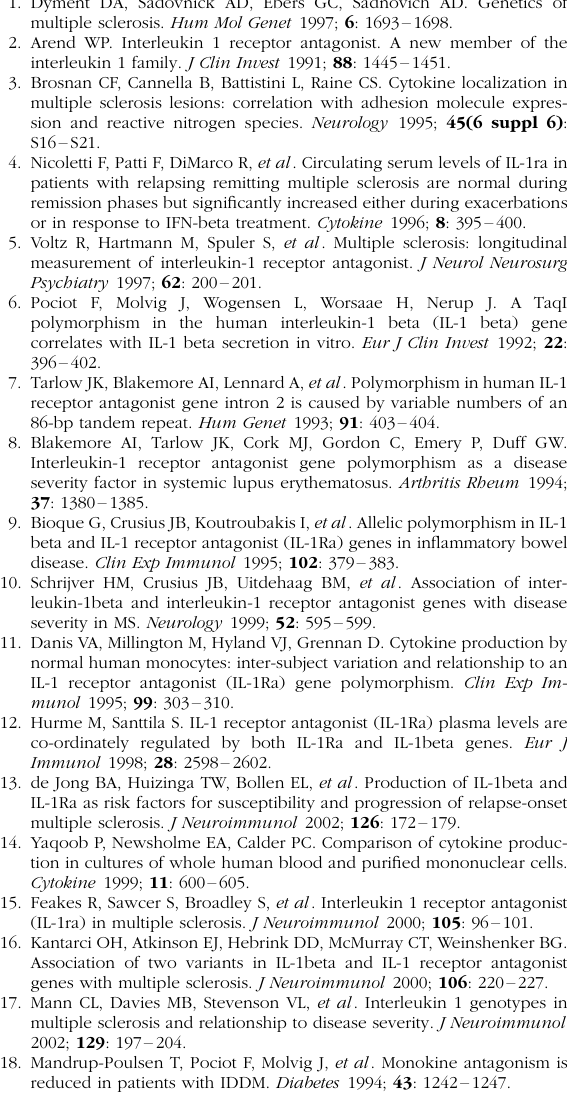
Table 2. IL-1 b /IL-1ra ratios after 6 and 24 h